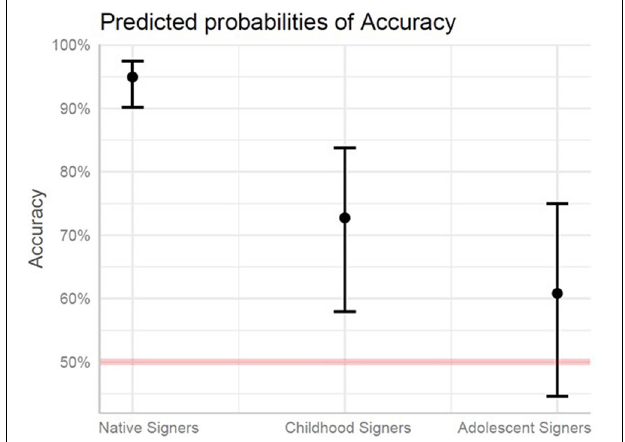
FIGURE 3 | Predicted probabilities of accuracy for native signers, childhood signers, and adolescent signers for morphology. The red line denotes chance responding